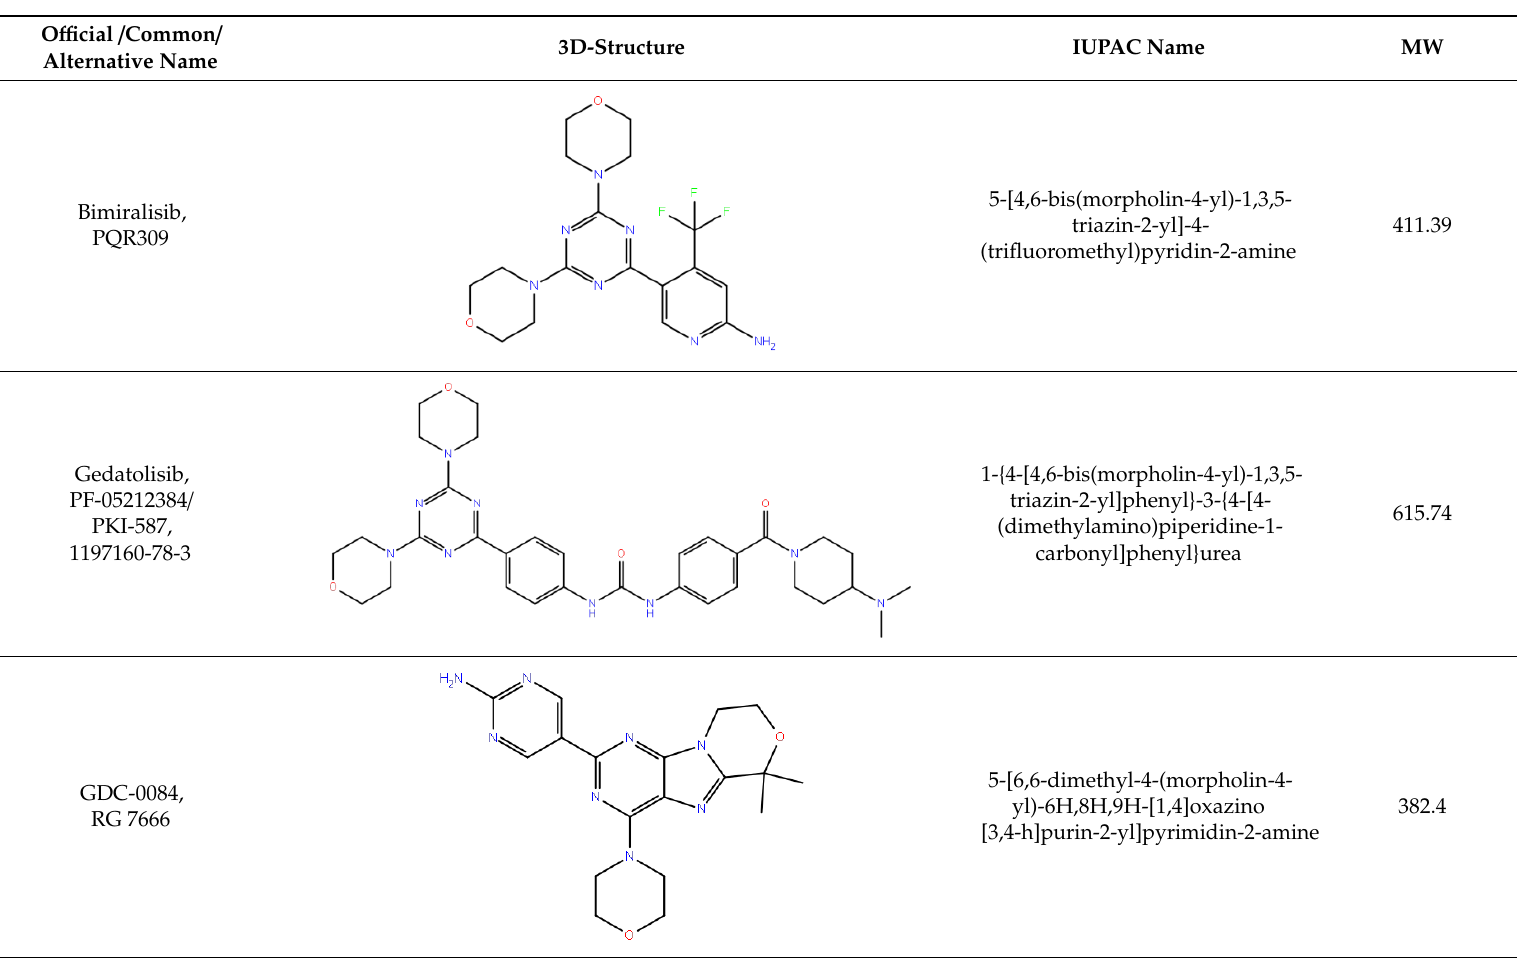
Table 3. Chemical structures of the three dual PI3K/mTOR inhibitors still in clinical development. Data collected from https://www.ebi.ac.uk/chembl/ [83], http://zinc.docking.org/substances/home/ [84], https://pubchem.ncbi.nlm.nih.gov/ [85], https://www.drugbank.ca/ [86], https://fdasis.nlm.nih.gov/srs/. MW, molecular weight. IUPAC, International Union of Pure and Applied Chemistry. Additional dual PI3K/mTOR inhibitors are presented in Table S1.